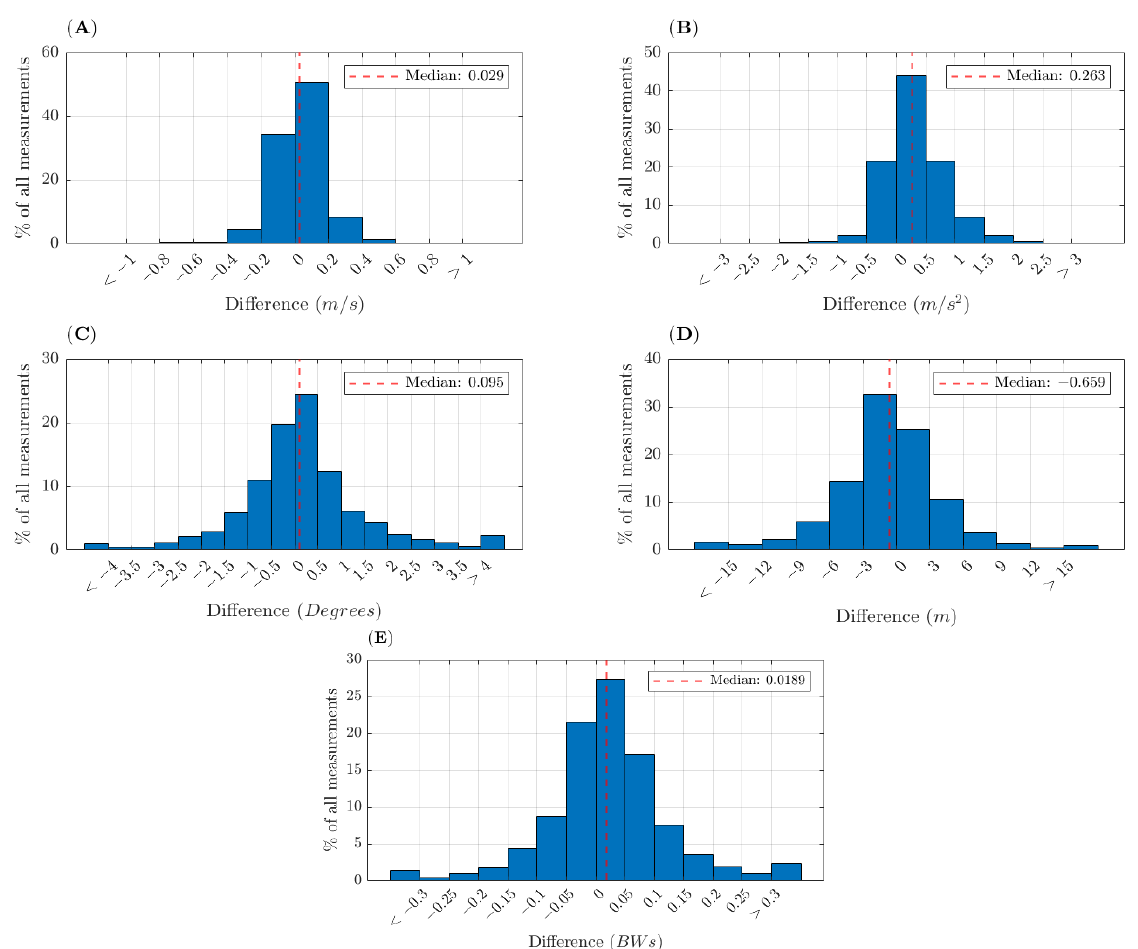
Figure 4. ( A ) Histograms for turn error in speed ( ∆ | v |/Turn), ( B ) acceleration ( ∆ | a |/Turn), ( C ) trajectory incline ( ∆ Incline/Turn), ( D ) turn radius ( ∆ Turn radius/Turn), ( E ) impulse ( ∆ Impulse/Turn). The histograms use all data from recreational and competitive skiing pooled together.